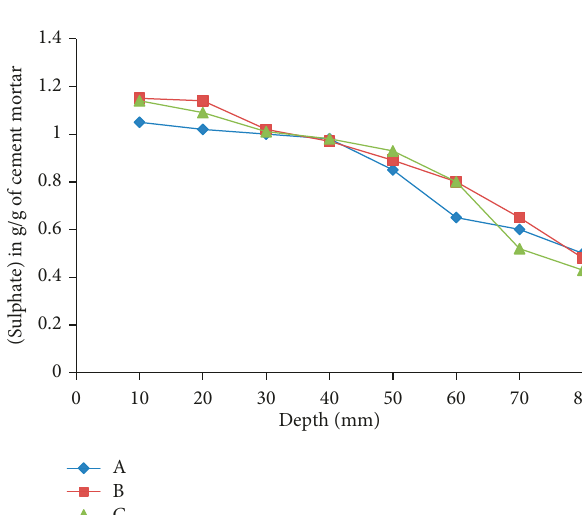
Figure 17: Sulphate profiles at w/c 0.6.